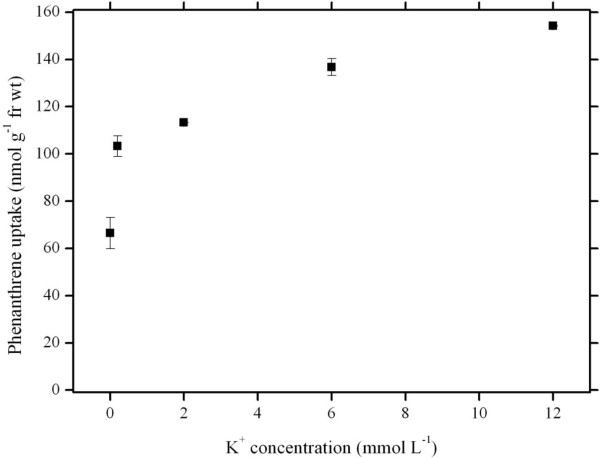
K+-stimulated phenanthrene uptake by wheat roots. The uptake of phenanthrene was performed at 25°C for 4 h in modified Hoagland nutrient solutions (i.e., potassium ions were replaced with sodium ions in nutrient solution, pH 5.5) with 5.62 μM phenanthrene. Data points represent mean and SD values of triplicates. Error bars do not extend outside all data points. fr wt, Fresh weight.